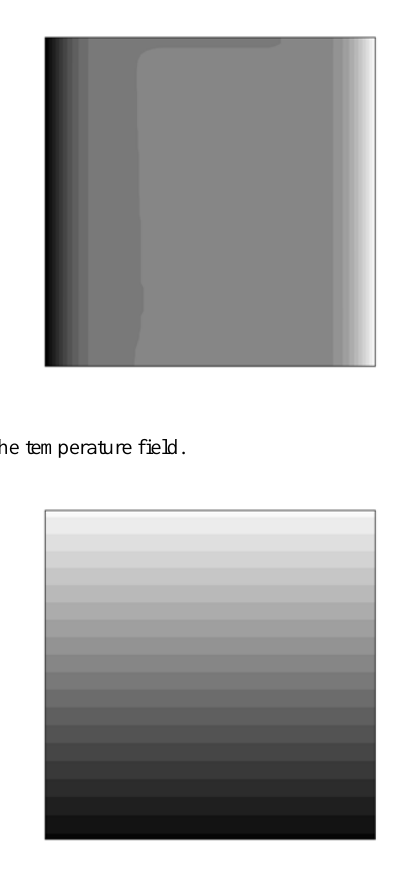
Fig.3. The pressure